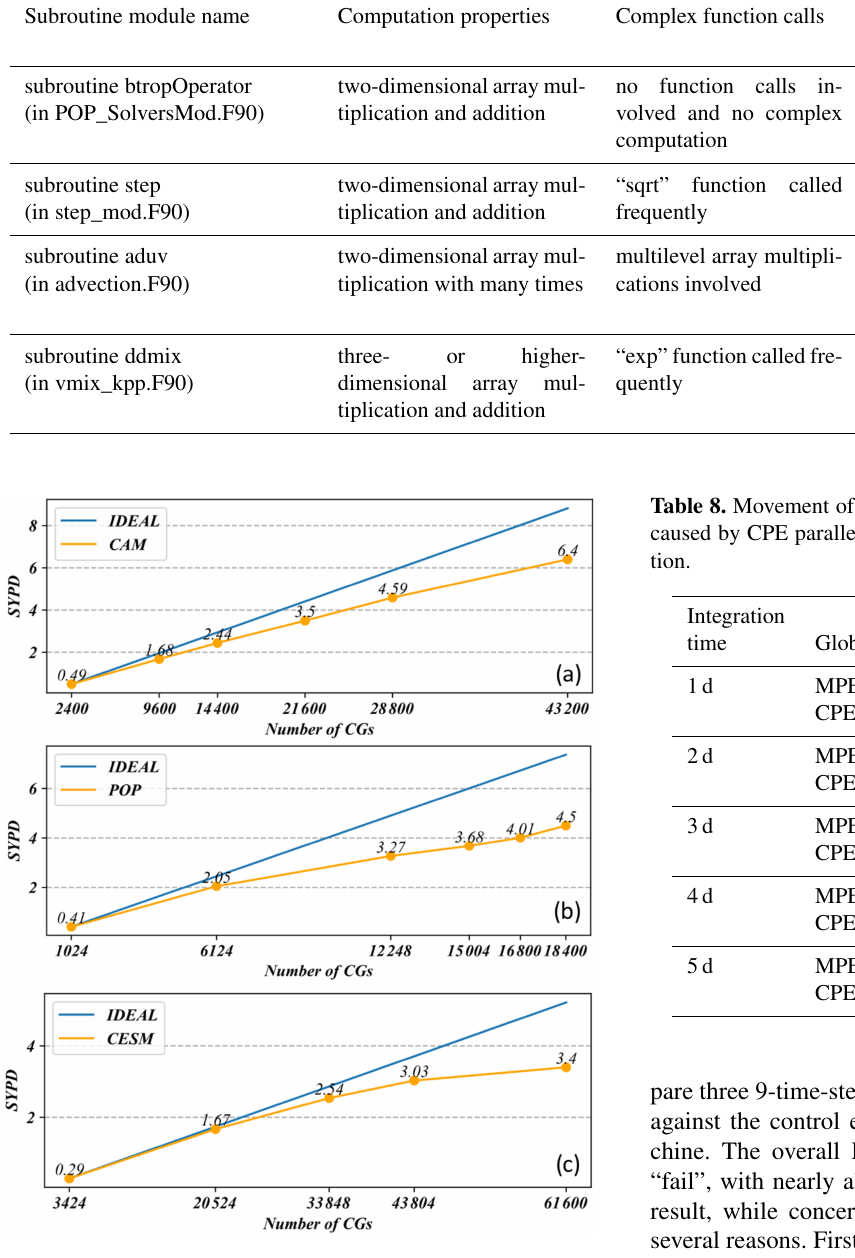
Figure 9. Scalability of (a) CAM5, (b) POP2, and (c) CESM-HR optimization. The performance of the model is given in terms of simulation years per day (SYPD) and number of core groups (CGs).